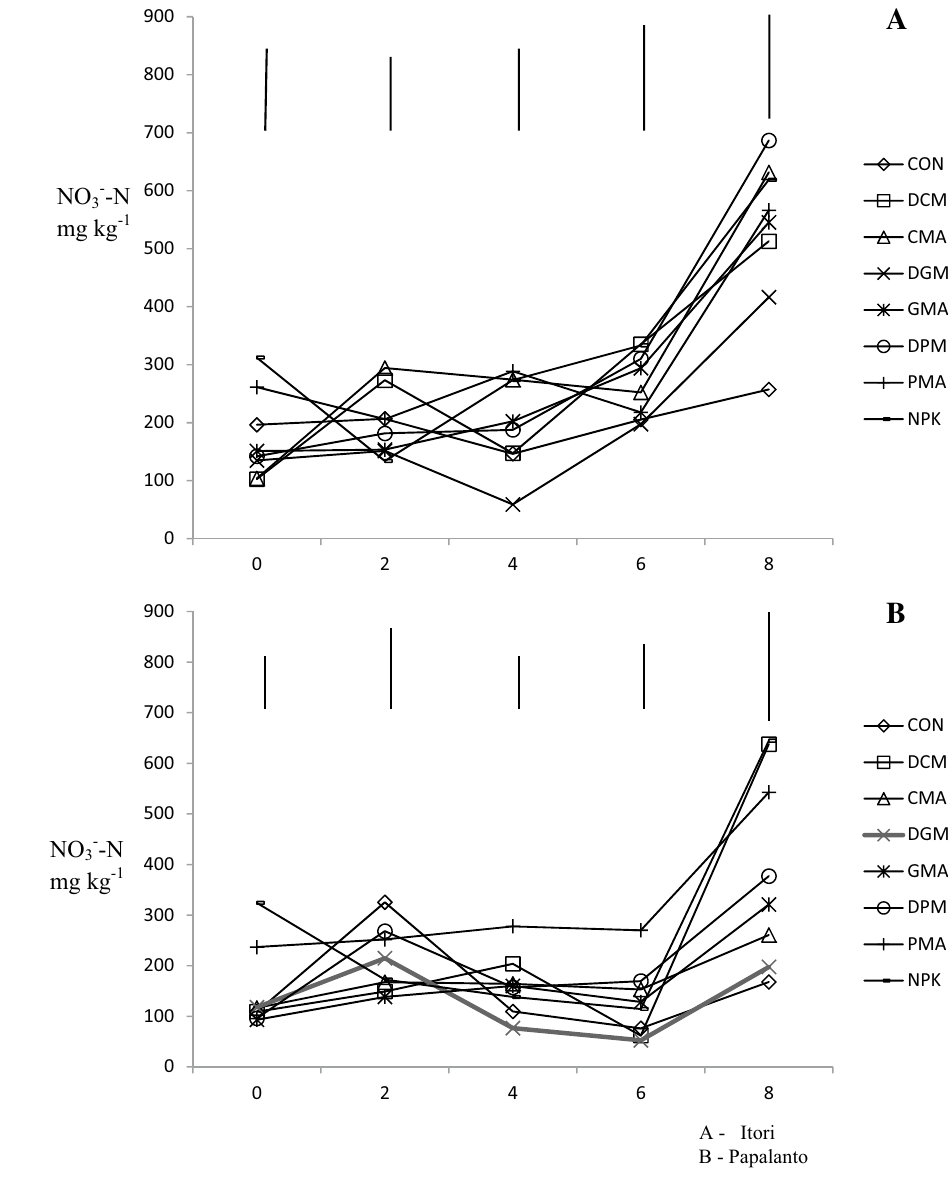
Fig. 6 Changes in